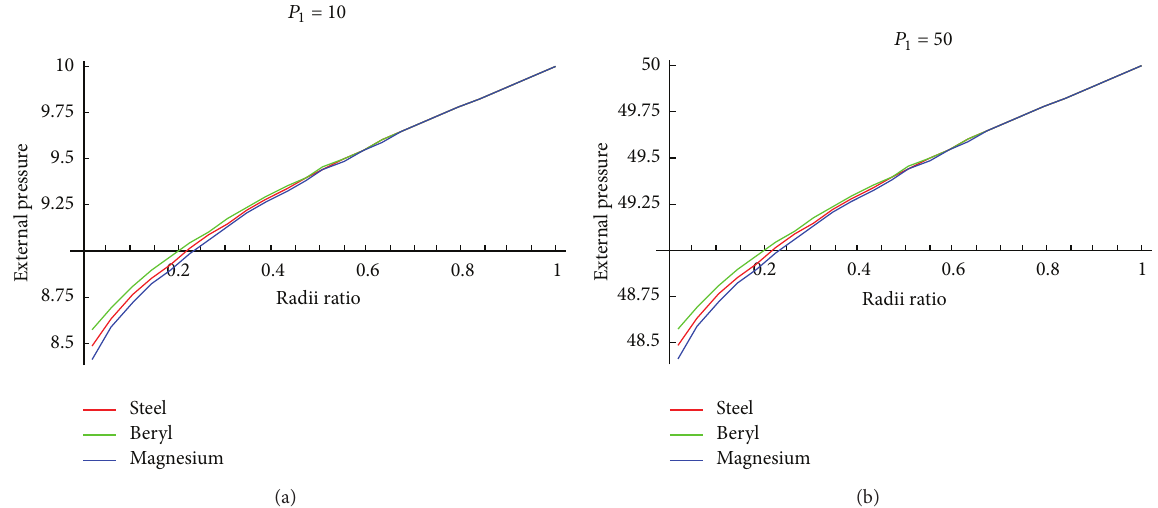
Figure 3: External pressure required for initial yielding when internal pressure 𝑃 1 = 10 , 50 for isotropic (steel) and transversely isotropic material (beryl and steel).